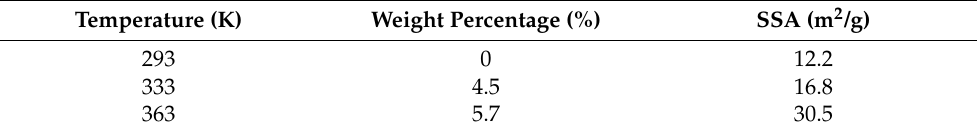
Table 7. Specific surface area and weight percentage of synthetic LiBO 2 . Temperature (K)